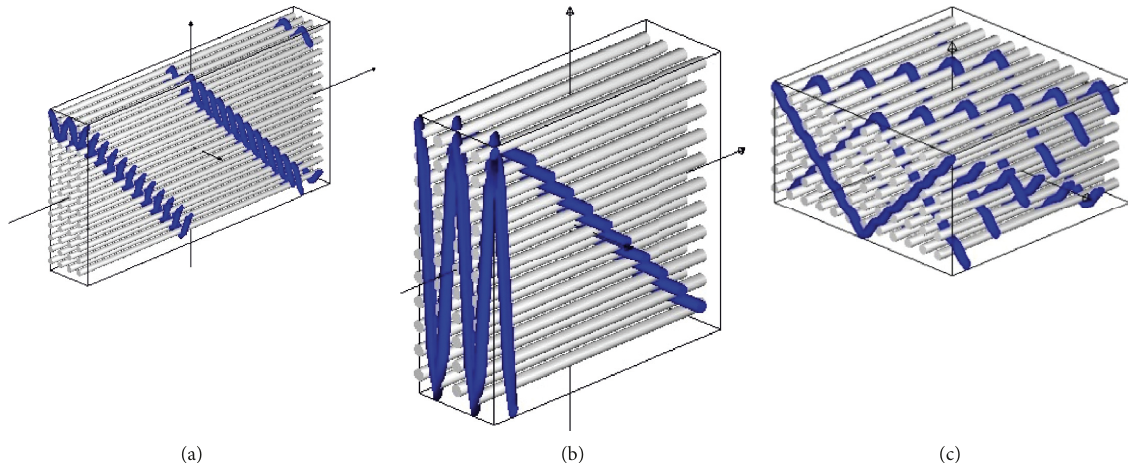
Figure 14: Geometric models of 3D warp interlock fabrics used as fibrous reinforcements for composite part of the impacted